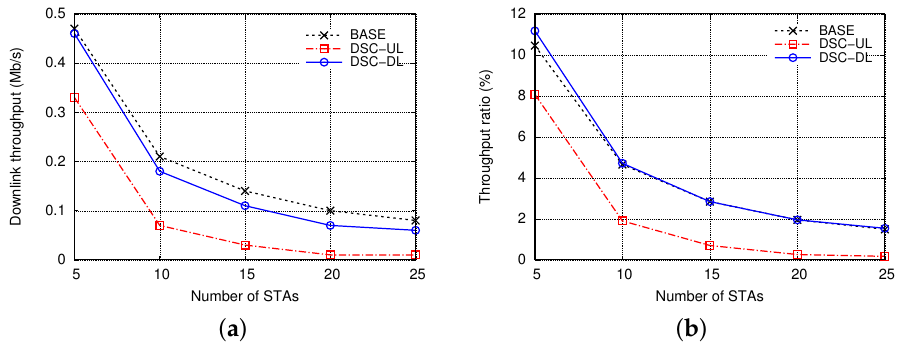
Figure 5. Comparison of ( a ) downlink throughput and ( b ) its ratio with respect to number of stations.